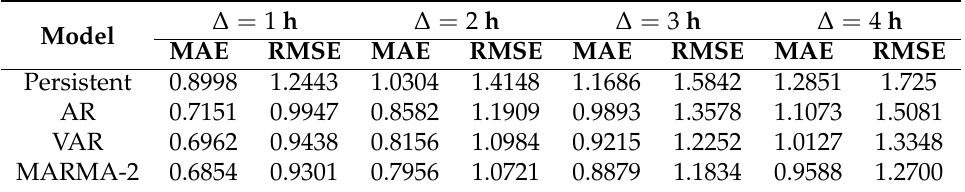
Table 3. RMSE and MAE performances of the persistent, AR, VAR and MARMA models according the forecast lead time ( ∆ ).